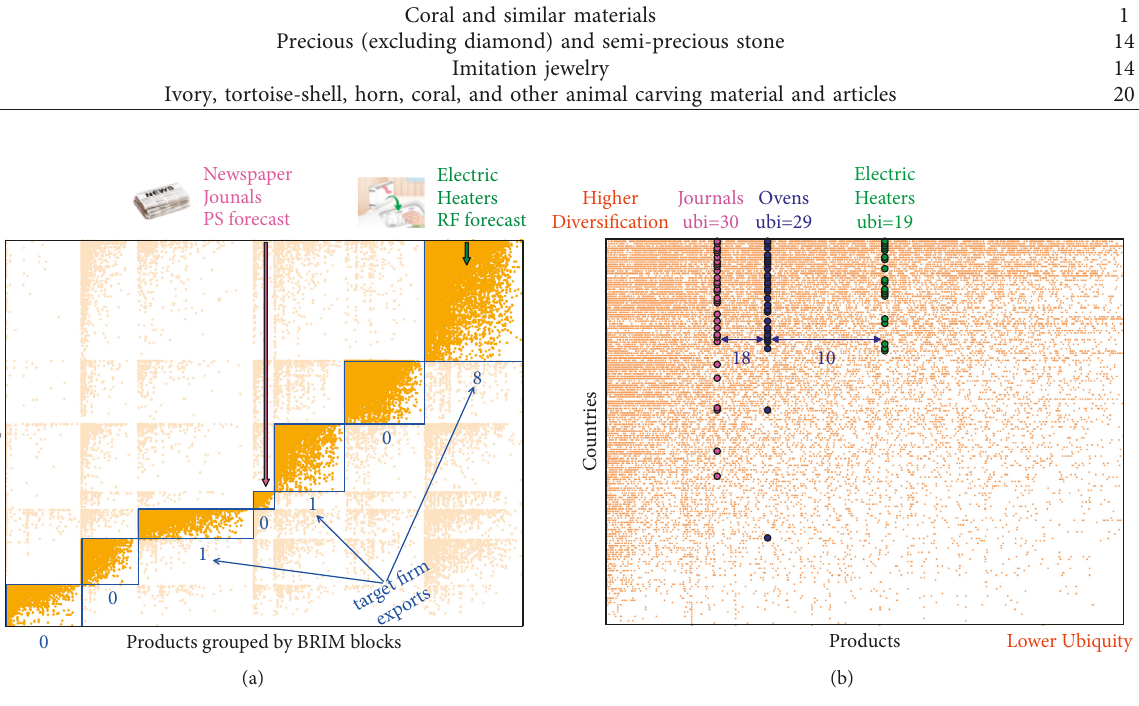
Figure 1: Visual representation of the predictions given by product space built on countries and random forest built on firms. (a) Matrix representation of the firm-product network. The products are grouped in blocks detected by the BRIM community detection algorithm. Under each block we report the number of products that belong to the exports of the target firm, firm B (selling large kitchens). The random forest prediction (electric heaters, green arrow) falls in the block in which the target firm has 8 products; the magenta arrow points to the most probable future export (newspapers) according to a product space model built on country-level data and falls in a block in which the firm has no products. (b) Country-product network. The products are sorted in decreasing order of ubiquity while the countries are sorted in increasing order of diversification. We highlighted in blue a product exported by the target firm—ovens. As expected, the product space forecast for the target firm is a more ubiquitous (simpler) product that is exported by many countries and so has many co-occurrences (18) with the ovens. The random forest forecast is a less ubiquitous (more complex) product and for this reason it has fewer co-occurrences (10) with the